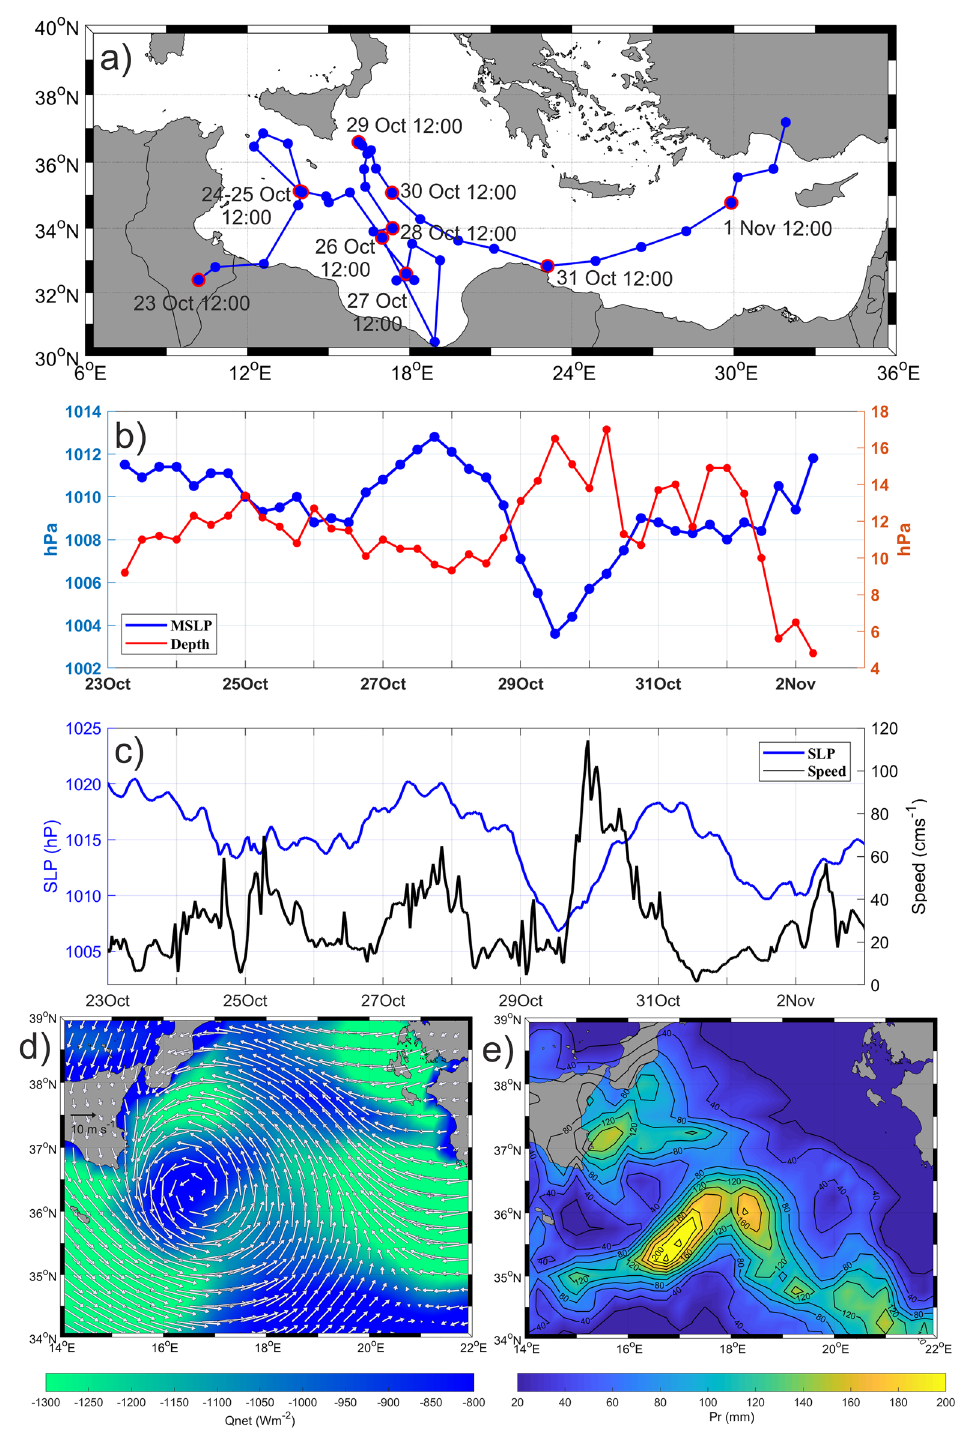
Figure 2. ( a ) 6 h Medicane Apollo track between 23 October 2021 12:00 UTC to 2 November 2021 06:00 UTC (blue dots); Medicane daily positions at 12:00 UTC are circled in red. Time series of ( b ) MSLP and cyclonic depth (i.e. a metric for the cyclone intensity) derived from ERA5, ( c ) SLP and current speed derived from drifter IMEI 300234067977120. Cumulative heat losses ( d ) and precipitation ( e ) in the period 27–30 October